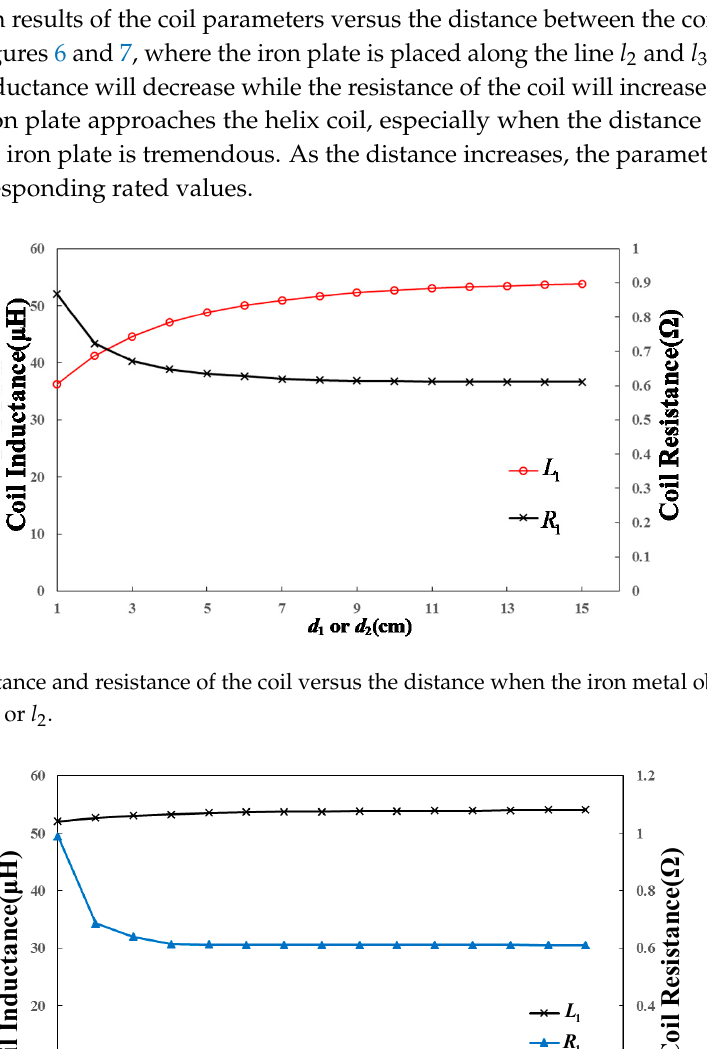
Table 2. Parameters of the WPT system with Class-E inverter.